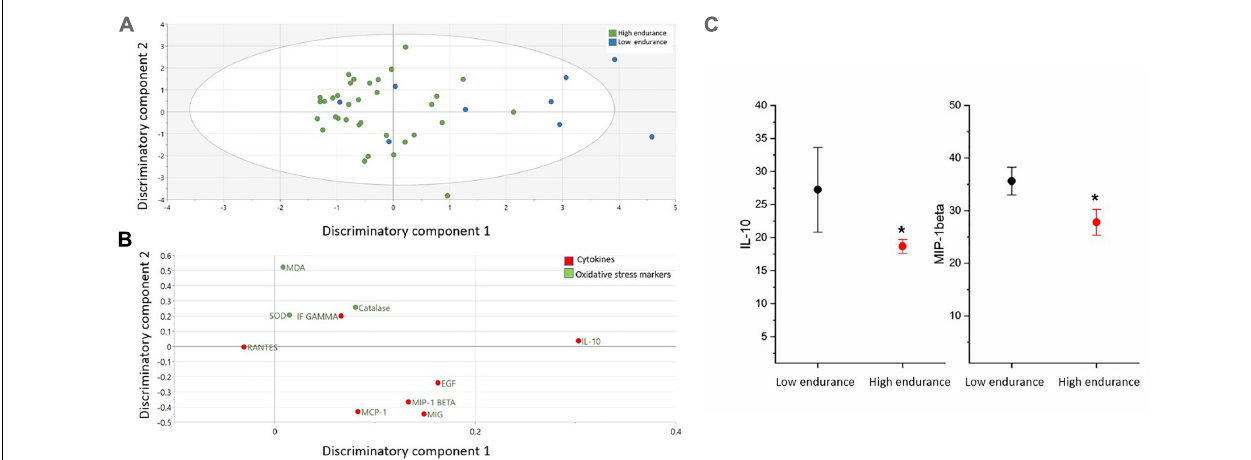
FIGURE 3 | Differences in cytokines and oxidative stress markers between endurance groups (low and high). (A) The score plot of OPLS-DA model comparing analytes from two endurance groups exhibits one class-discriminatory component 1 ( x -axis) versus an orthogonal component 2 ( y -axis). (B) The corresponding loading plots shows top associated analytes differentiating low and high endurance groups (C) . Significant differences in cytokines and oxidative stress markers between the two groups by KS test (* p <